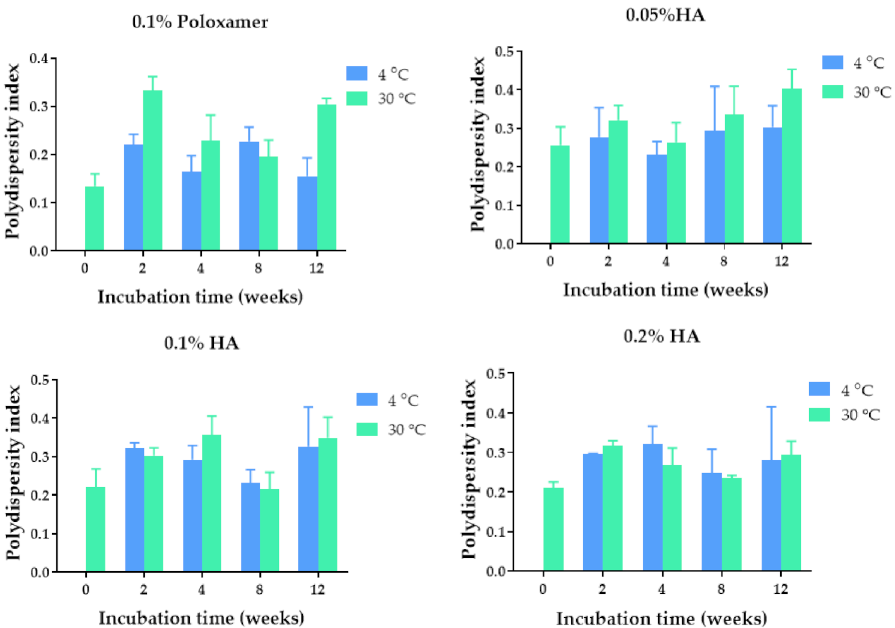
Figure 2. Polydispersity index of the quercetin-loaded PLGA NPs after fresh preparation and storage in deionized water for 2, 4, 8, and 12 weeks at 4 ◦ C and 30 ◦ C.